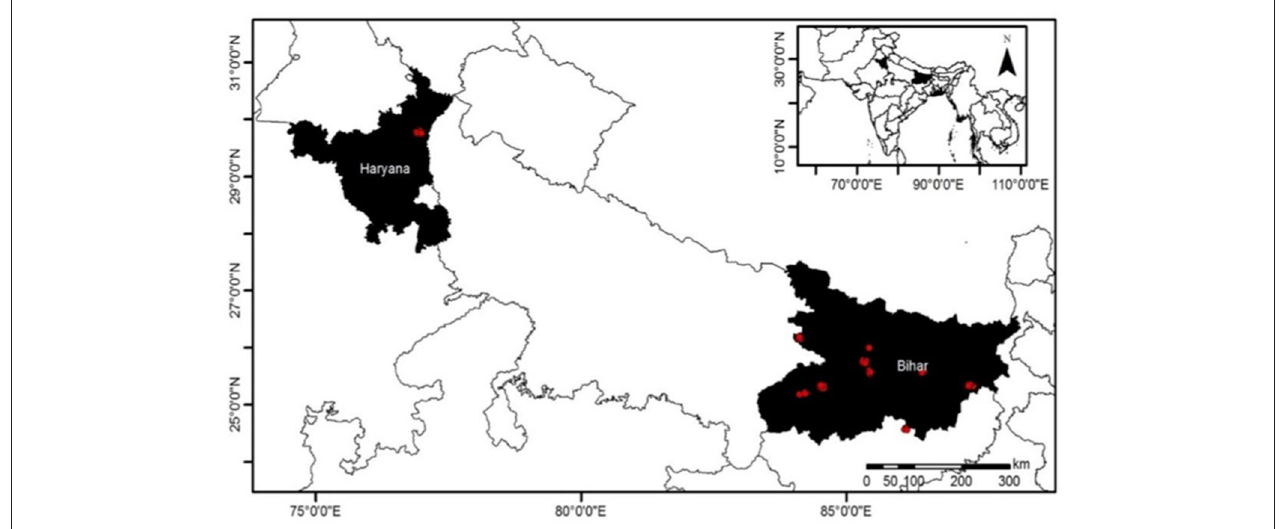
FIGURE 1 | Map of study village (red) in Bihar and Haryana explored in this study.